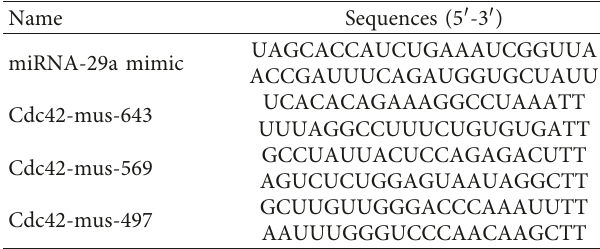
Table 1: The sequences of miR-29a mimic and Cdc42-mus.